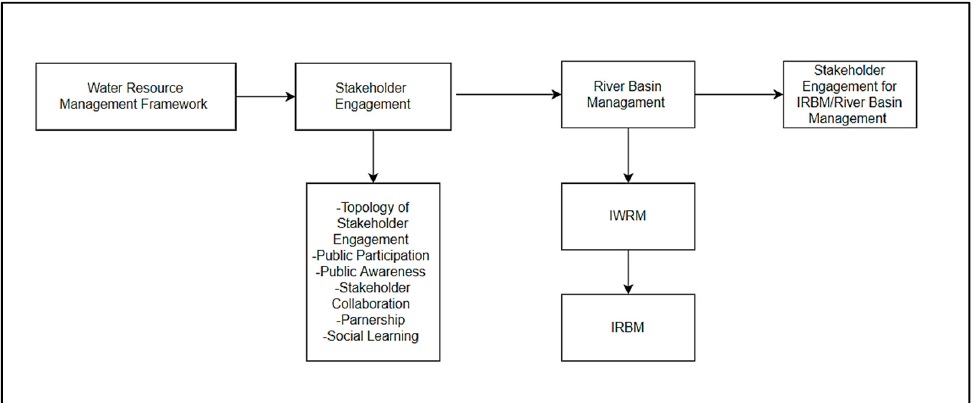
Figure 2. Keyword filtering stage for systematic bibliometric